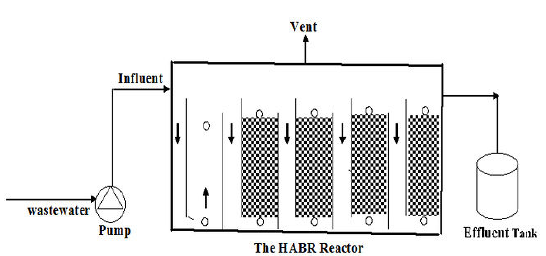
Fig. 1. The FABR and the E-FABR